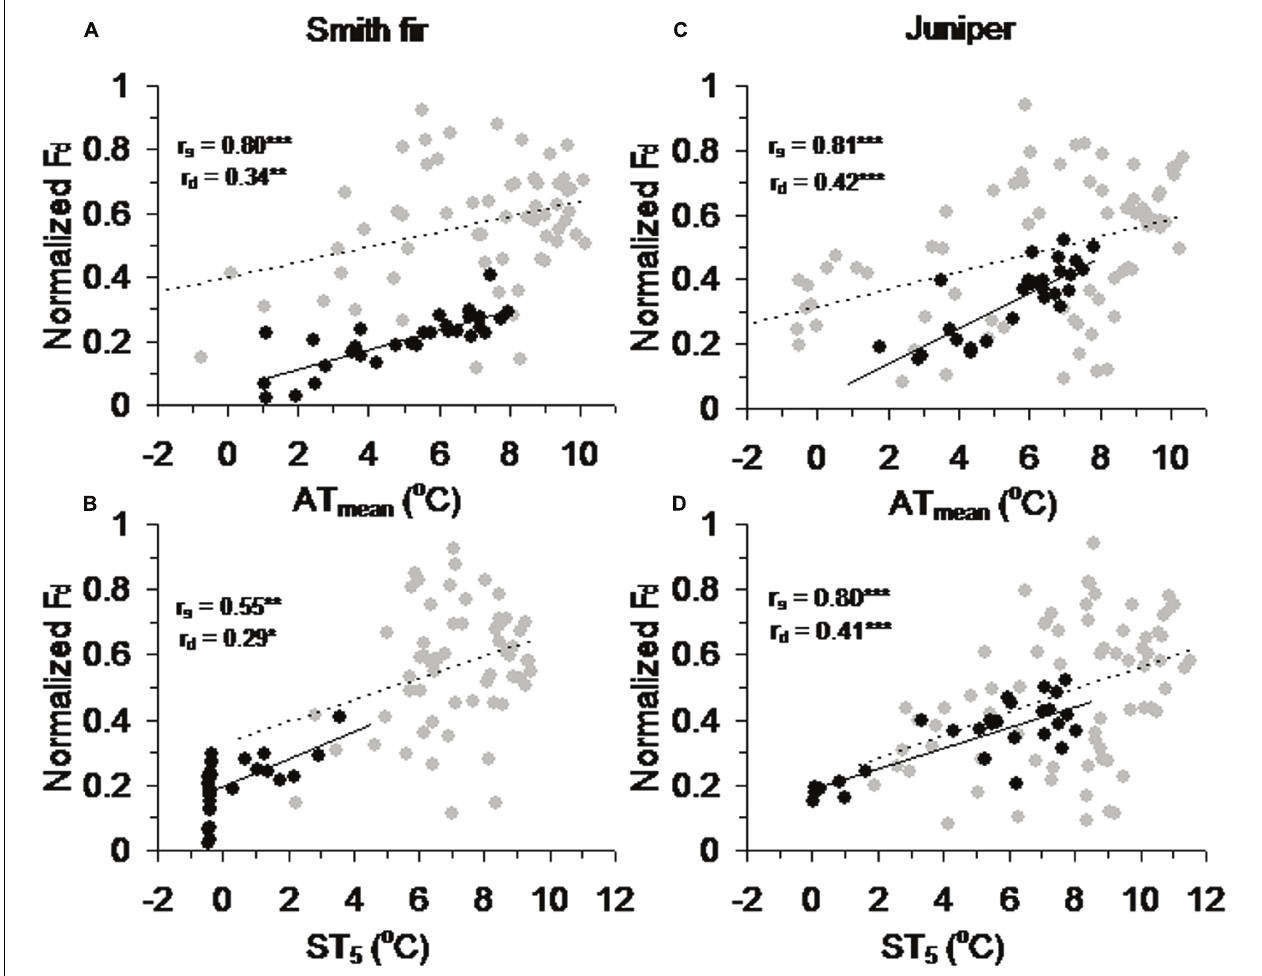
FIGURE 5 | Correlations between normalized daily sum sap flow density (normalized F d ) across pre- and post-summer solstice growing seasons of Smith fir trees and meteorological factors of (A) mean air temperature (AT mean ) and (B) mean soil temperature at 5 cm (ST 5 ), and of juniper trees and meteorological factors of (C) AT mean and (D) ST 5 . The solid trend line ( r s ) is for normalized F d in pre-summer solstice (black circle), and the dashed trend line ( r d ) is for normalized F d in post-summer solstice (gray circle). ∗ P < 0.05, ∗∗ P < 0.01, ∗∗∗ P <